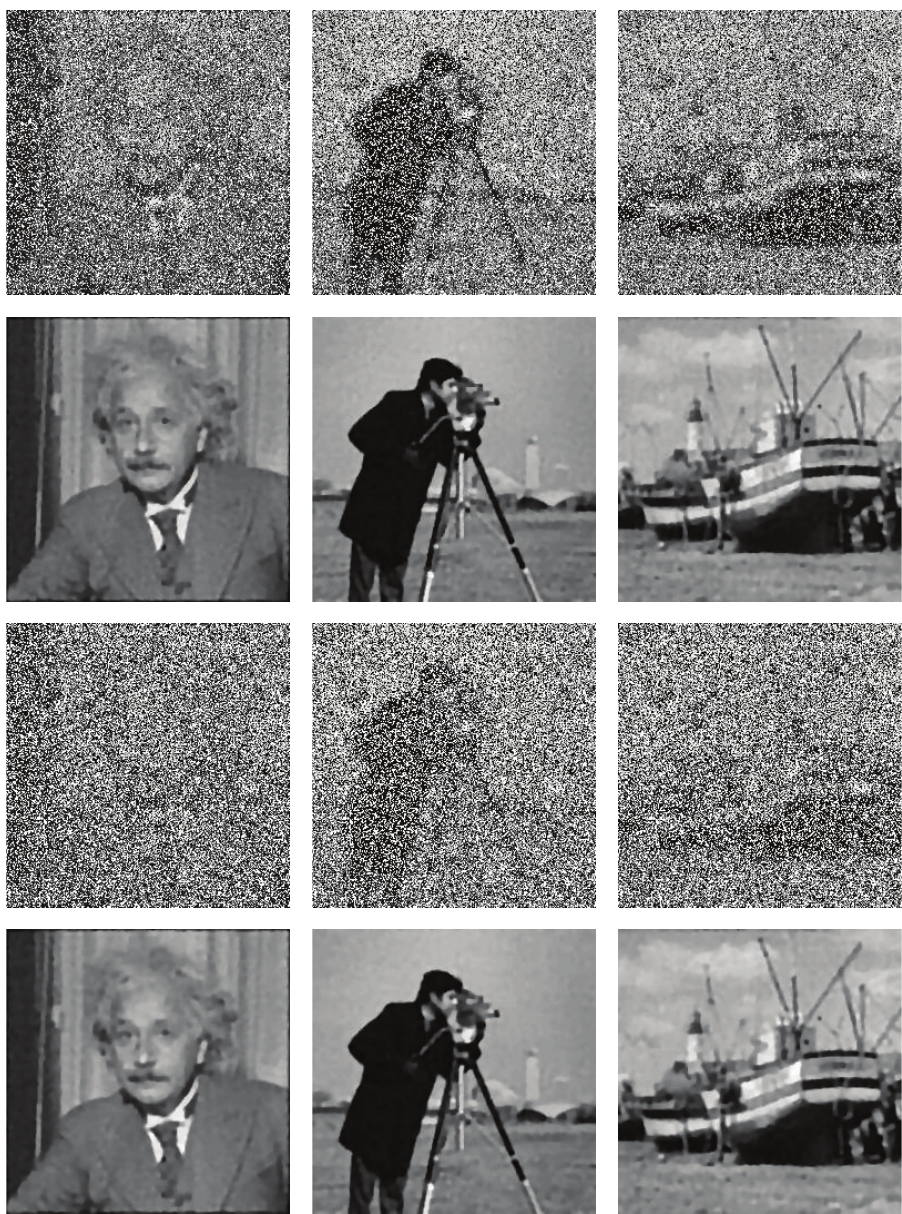
Figure 5: Top: images blurred with out-of-focus kernel of radius 3 and then corrupted by Gaussian noise with 𝜎 = 5 and salt-and-pepper noise with 𝑠 = 5 0%. The second line: results restored by MNID-ADMM ( 𝛼 1 = 0.9 , 𝛽 1 = 𝛽 2 = 𝛽 3 = 0.05 ). The third line: Images blurred with out-of-focus kernel of radius 3, and then corrupted by Gaussian noise with 𝜎 = 5 and salt-and-pepper noise with 𝑠 = 70 %. Bottom: results restored by MNID-ADMM ( 𝛼 1 = 0.9 , 𝛽 1 = 𝛽 2 = 𝛽 3 = 0.05